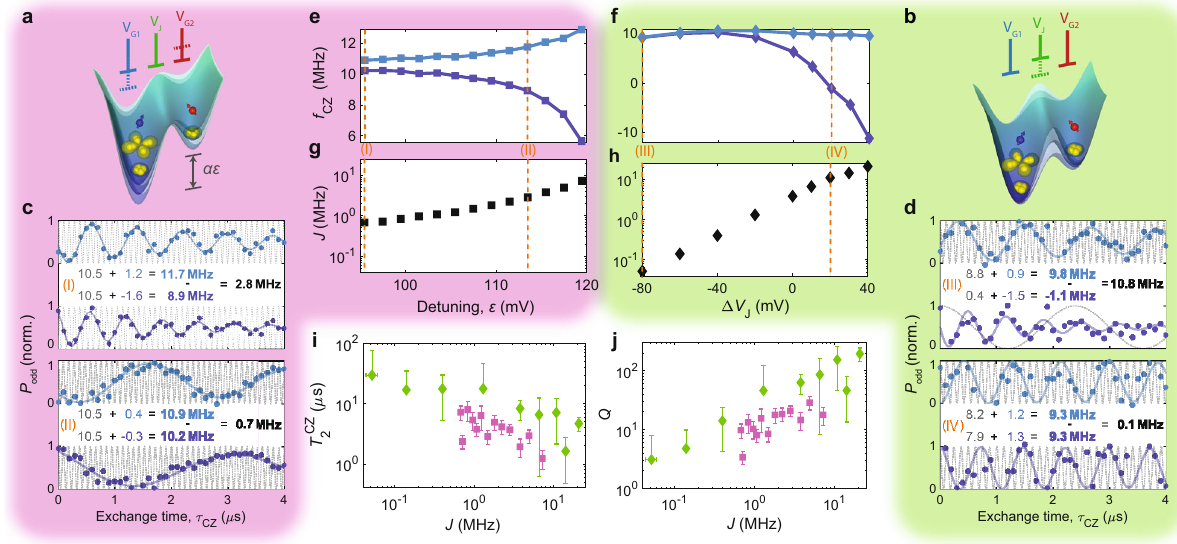
Fig. 2 Exchange control. a , b Schematic showing the two different mechanisms to electrically control exchange coupling between quantum dots, by a voltage detuning between G1 and G2 gate, and b barrier control with J gate. c , d Examples of CZ oscillations controlled via c detuning or d J gate. We apply a pulse sequence X1 − CZ − X1, where X1 is a π rotation around the x -axis of Q1, then measure the probability of an odd spin parity P odd . Orange 2 Roman numbers in each panel correspond to the applied voltage indicated in e – h , drawn as orange dashed lines. Blue and red markers correspond to the (cid:1) (cid:1) (cid:3) (cid:3) (cid:1) (cid:1) ð 1 (cid:3) cos ð 2 π f t Þ e (cid:3) t = T CZ 2 Þ þ b . The normalized measured P odd with Q2 initialized as # , respectively. The data are fi tted using the equation P odd ¼ A or " osc 2 Ramsey frequency f osc is displayed as blue or red text on the panel. In order to compensate the strong Stark shift induced by gate pulsing, we adopt different rotating frames, offset by a reference frequency f ref between experiments, as presented in grey dashed curves behind each measurement data set. We extract the CZ frequency f CZ = f ref + f osc in a common frame and the difference between f CZ ; Q2 ¼ # j i and f CZ ; Q2 ¼ " j i , which gives the exchange coupling frequency J , shown as black bold text. e , f The oscillation frequency f CZ as a function of e detuning or f J gate control. Blue and red line corresponds to Q1 = (cid:1) (cid:1) (cid:3) (cid:3) (cid:1) (cid:1) # and " , respectively. g , h Extracted exchange oscillation frequency J . i Damping time T CZ of the measured oscillations as a function of exchange (cid:1) (cid:3) 2 (cid:1) and for detuning (purple) and J gate control (green). j Quality factor Q ¼ J ´ T CZ coupling J , for Q2 = " as a function of J , extracted from i . Error bars 2 represents ± 5% fi tting